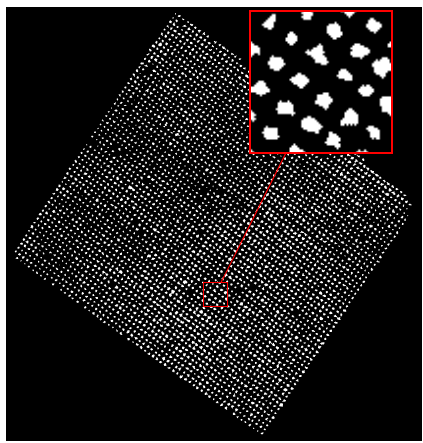
Figure 3. Binary image showing vine pixels with a value of 1 in